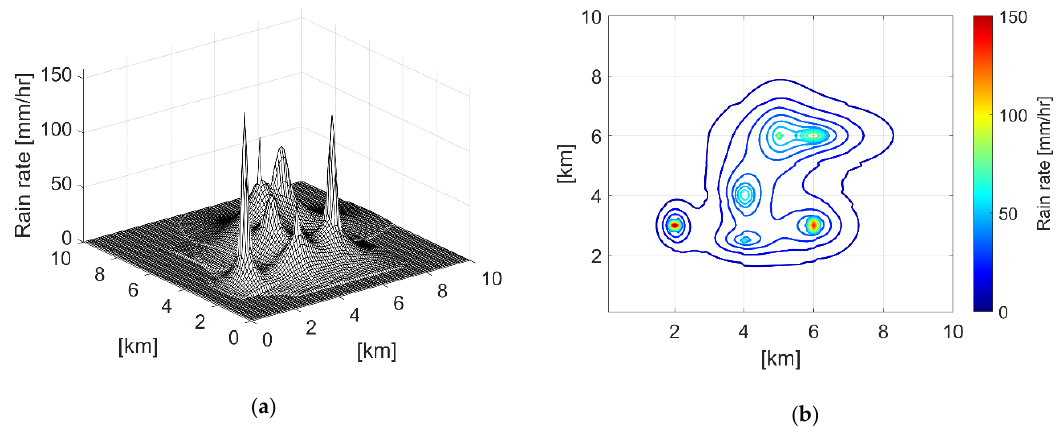
Figure 3. ( a ) 3D plot of a small-scale simulated rain field using the HYCELL model; ( b ) Contour plot of the rain field.